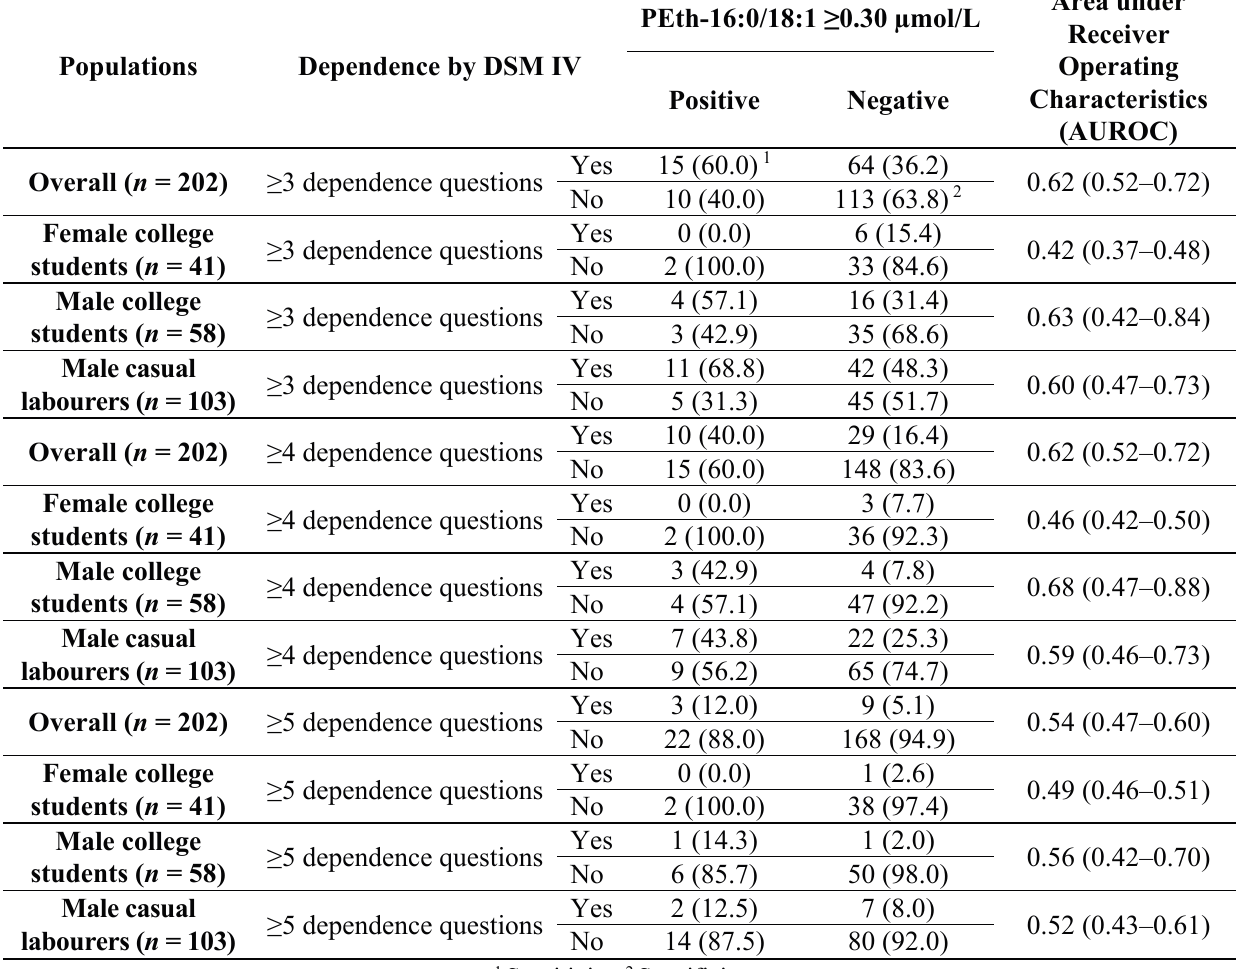
Table 3. Sensitivity and specificity of MINI results compared with PEth